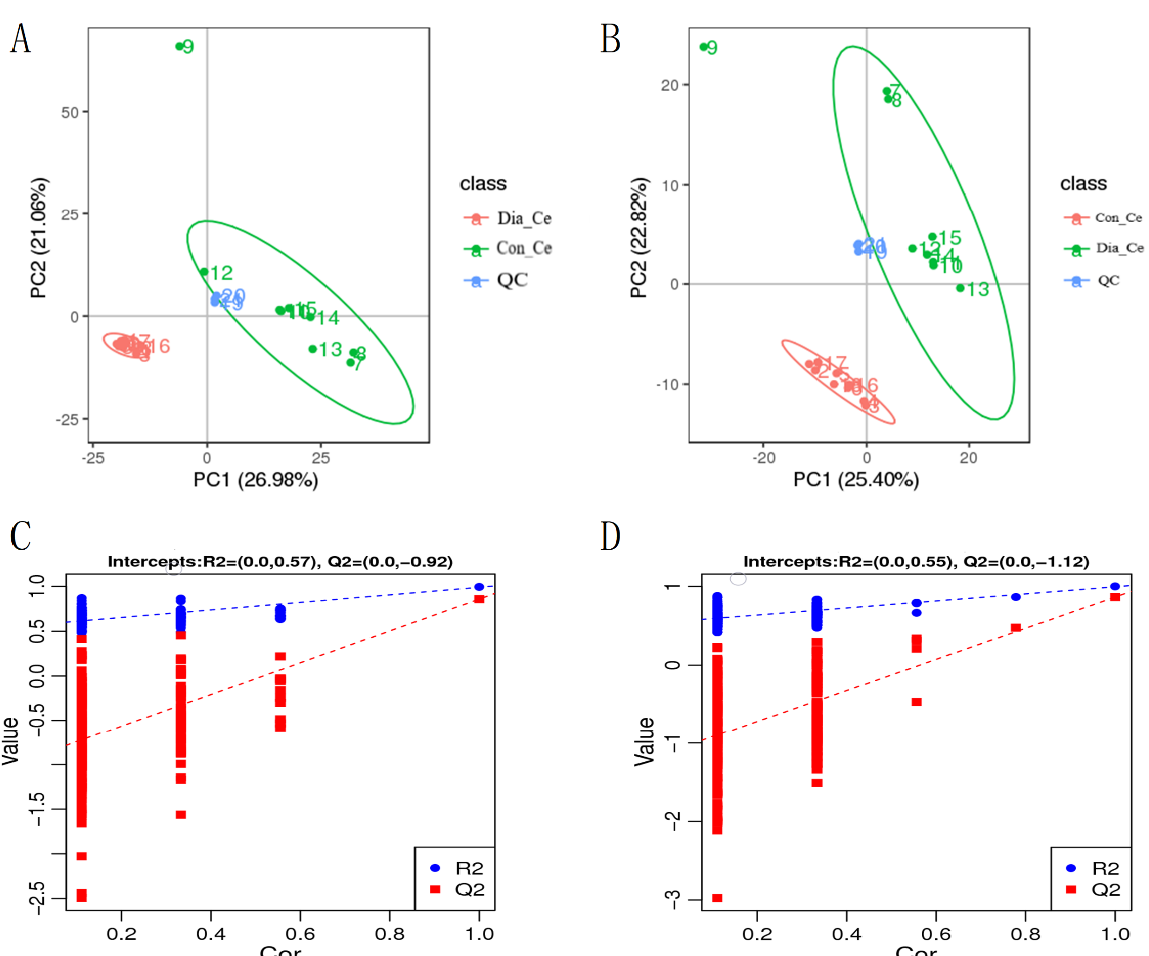
Figure 4. PCA and PLS-DA of fecal metabolites in cecum. ( A , B ) PCA score graph between Dia_Ce and Con_Ce; ( C , D ) permutation test from PLS-DA models. Note: ( A ,C): cationic mode; ( B , D ): anion mode.